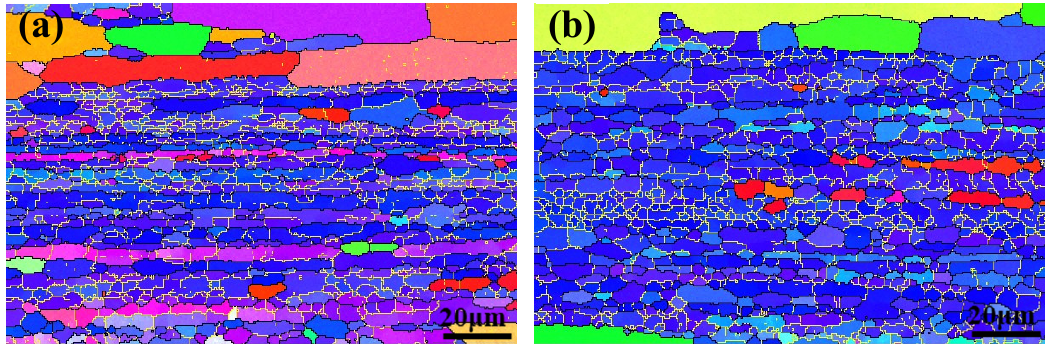
Figure 6. Electron back-scattered diffraction (EBSD) images of the specimens treated by the different aging treatments: ( a ) A1; ( b ) PCA.